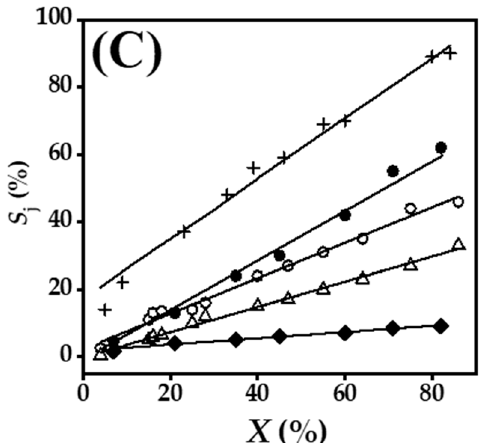
Figure 6. ( A ) Reaction rate ( R , mol Alkynol g Pd − 1 h − 1 ) and variation of selectivity ( S j , %) as a function of conversion ( X , %) for products from ( B ) − C ≡ C − → − C = C − bond partial reduction and ( C ) hydrogen bond migration / reduction in the hydrogenation of primary (solid bar and solid symbols), secondary (open bar and open symbols) and tertiary (hatched bar and crossed symbols) C 4 alkynols over Pd / Al 2 O 3 ; 3-buten-1-ol ( (cid:4) ),1-butanol ( (cid:8) ), crotyl alcohol + butyraldehyde ( (cid:117) ), 3-buten-2-ol ( (cid:3) ), 2-butanol ( ), 2-butanone ( (cid:52) ), 2-methyl-3-buten-2-ol ( × ) and 2-methyl-butan-2-ol ( + ). Note: solid lines provide a guide to aid visual assessment. Reaction conditions : T = 373 K, p = 1 atm.